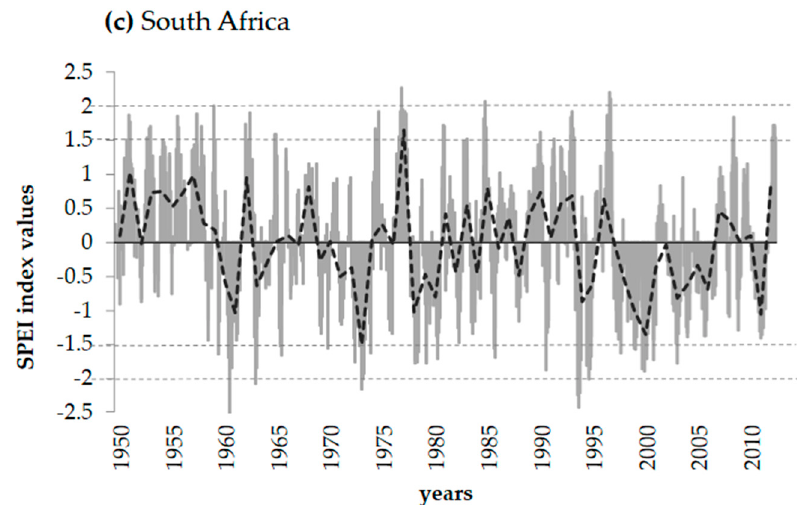
Figure 8. Calculated standardised precipitation evapotranspiration index (SPEI) with a time scale of 6 months for the periods 1950–2011 Germany ( a ), 1955–2014 Italy ( b ), and 1950–2012 South Africa ( c ). Grey bars indicate the monthly index and the black dotted graphs indicate the average drought index per year. Horizontal dotted lines show the SPEI drought categories: 1.5/ − 1.5 severe wet/dry; 2/ − 2 extreme wet/dry [59,64].